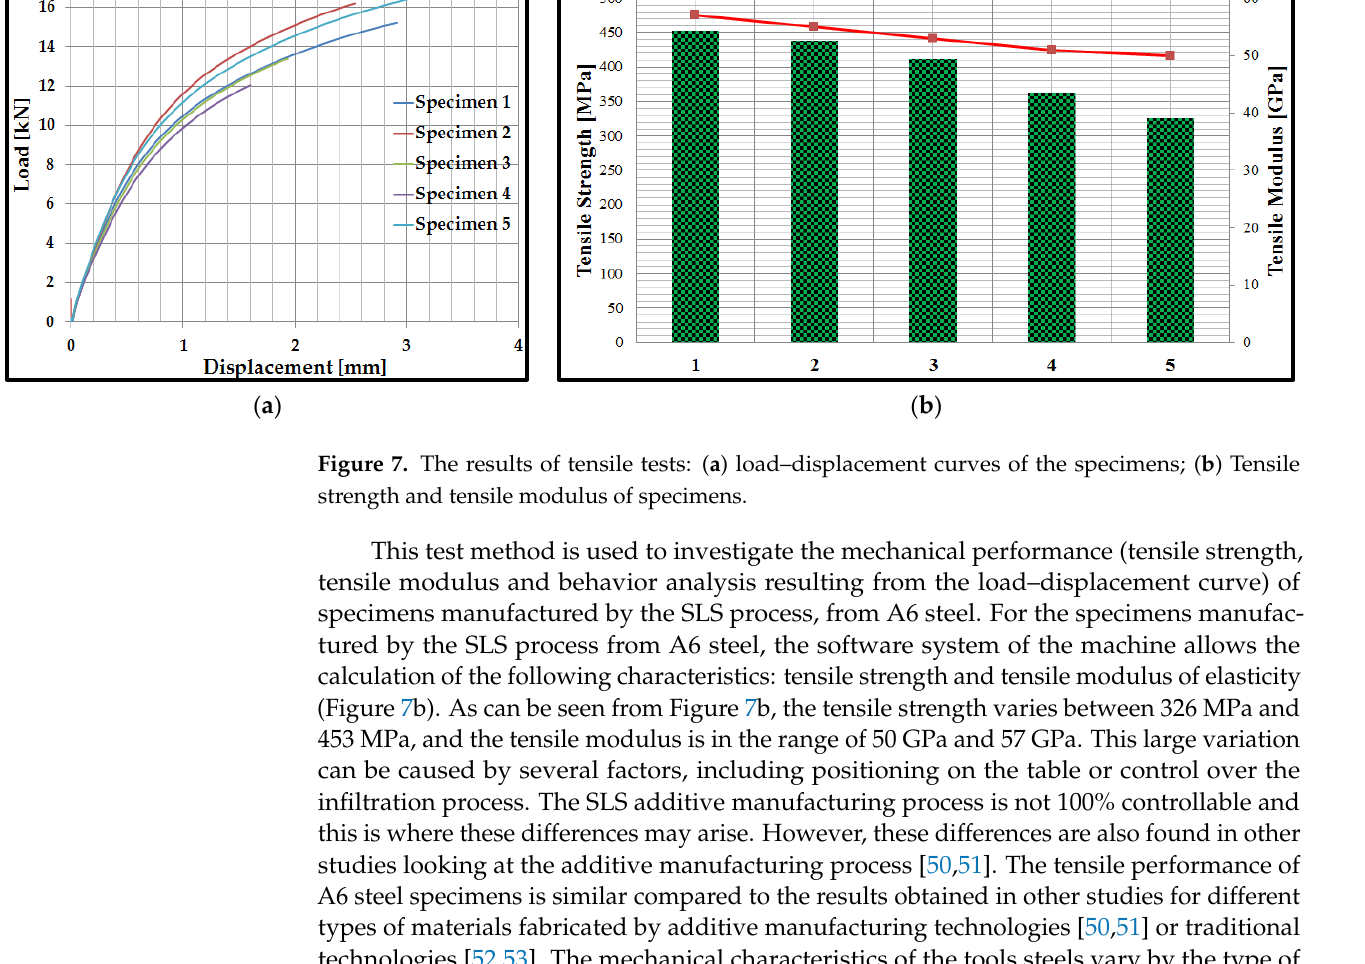
Table 6. Statistical indicators determined from tensile tests of A6 steel specimens.